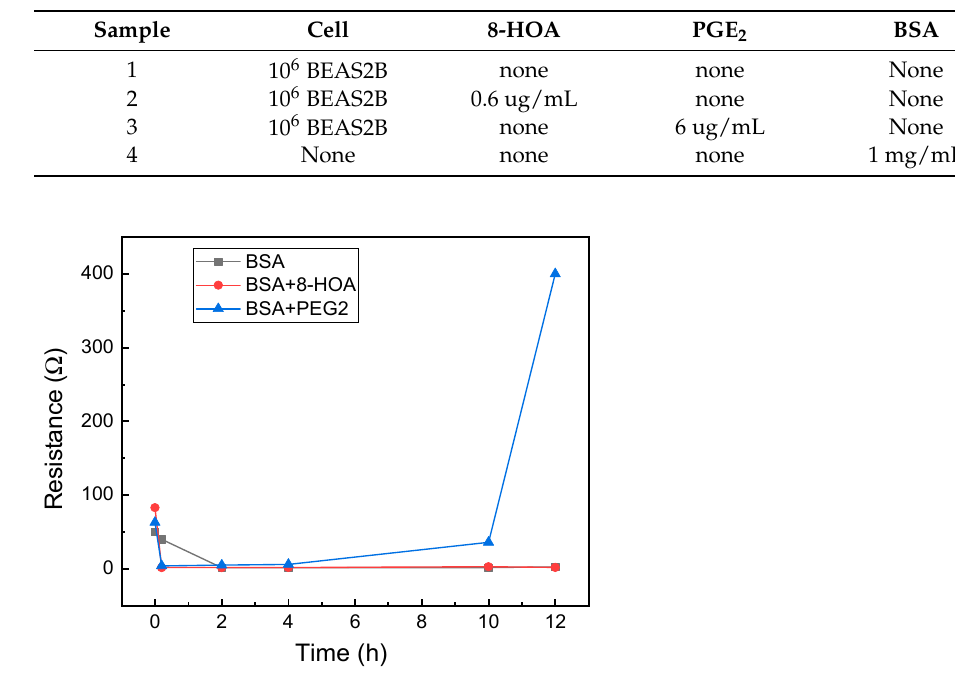
Figure 4. Resistance change measured using Ti 3 C 2 MXene-based sensors for BEAS2B